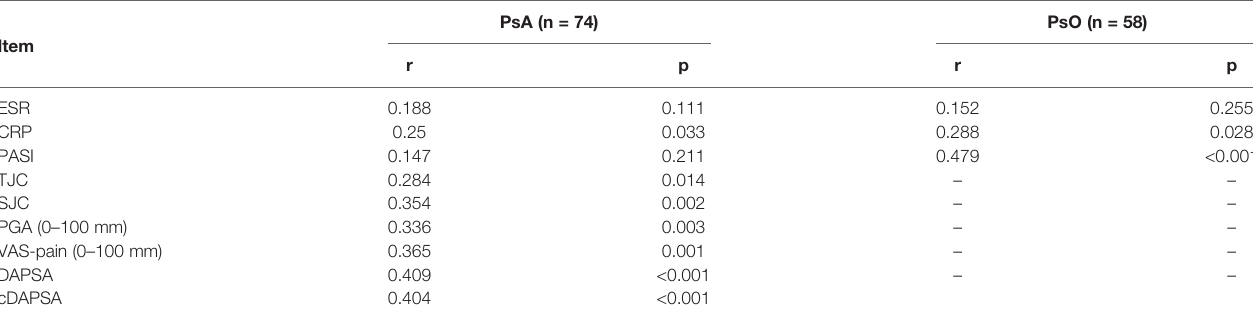
TABLE 2 | Correlations of serum MPO – DNA level with disease activity index at baseline.